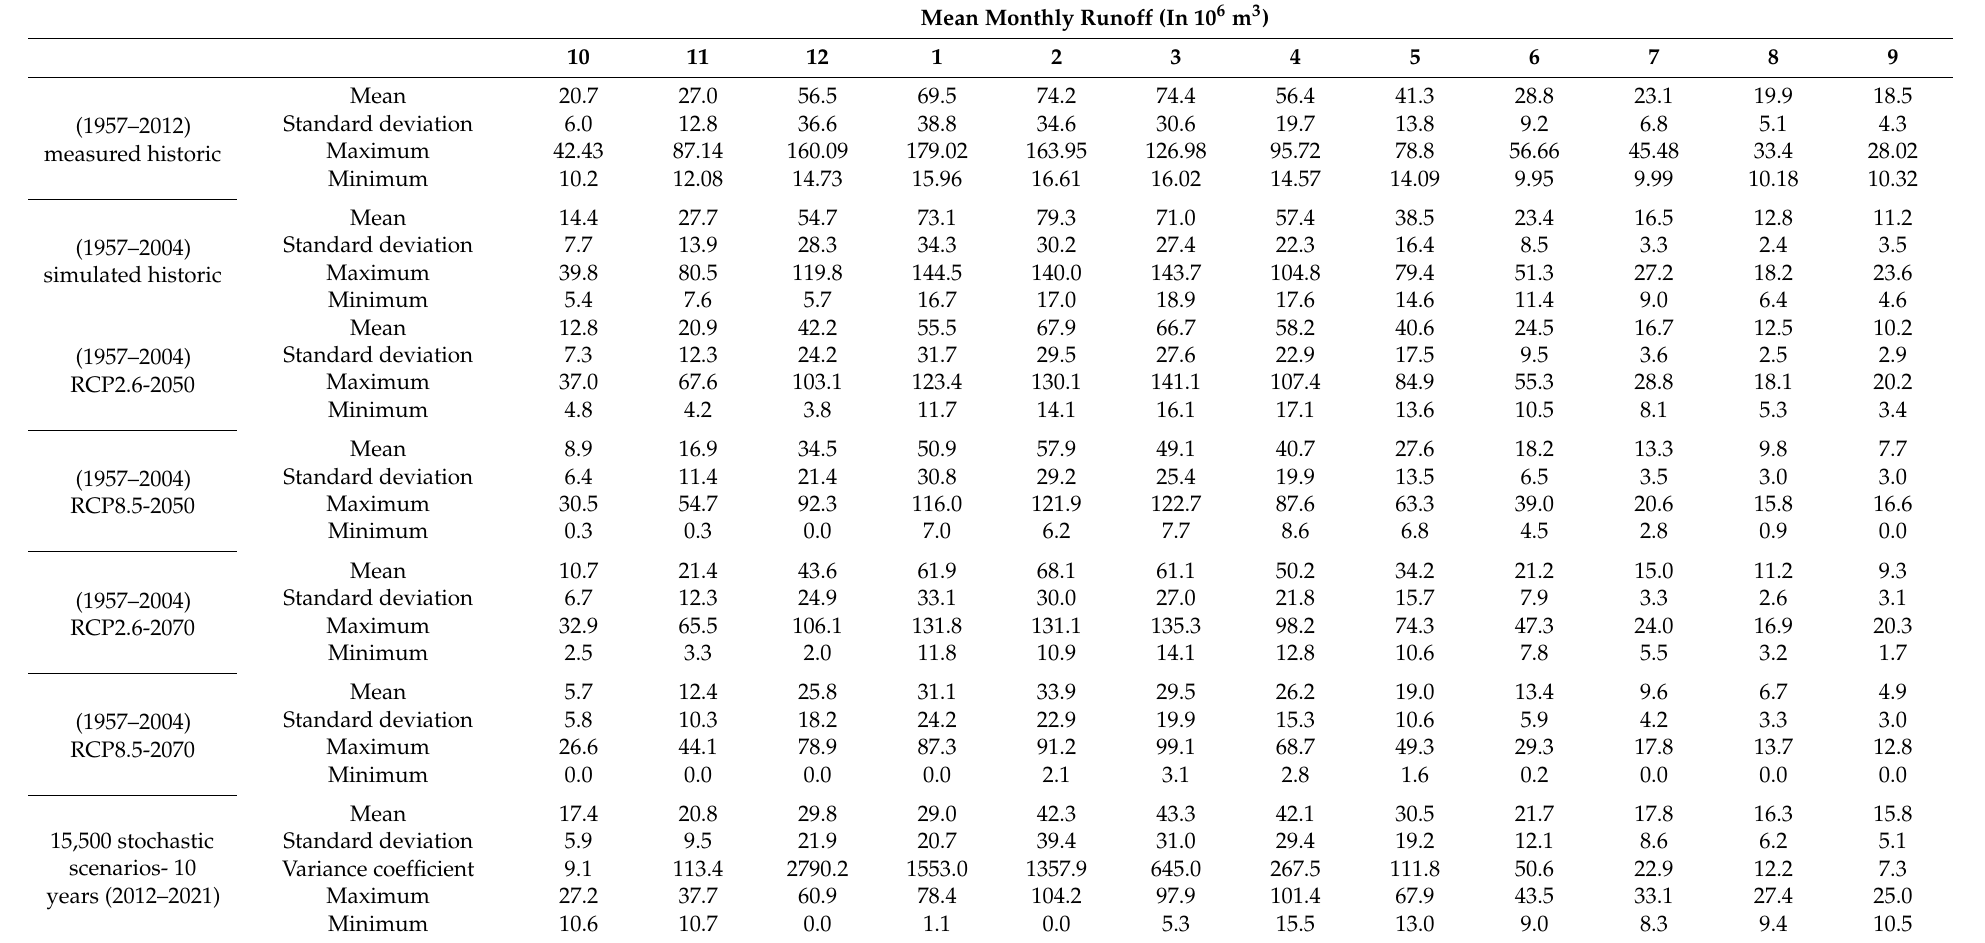
Table A3. Statistical characteristic of historic and future monthly water inflows into Ladhon Reservoir ( × 10 6 m 3 ) derived from the IPCC climatic scenarios in the near (2050) and the far (2070) future and the stochastic simulation (15,500 stochastic scenarios of 10 years